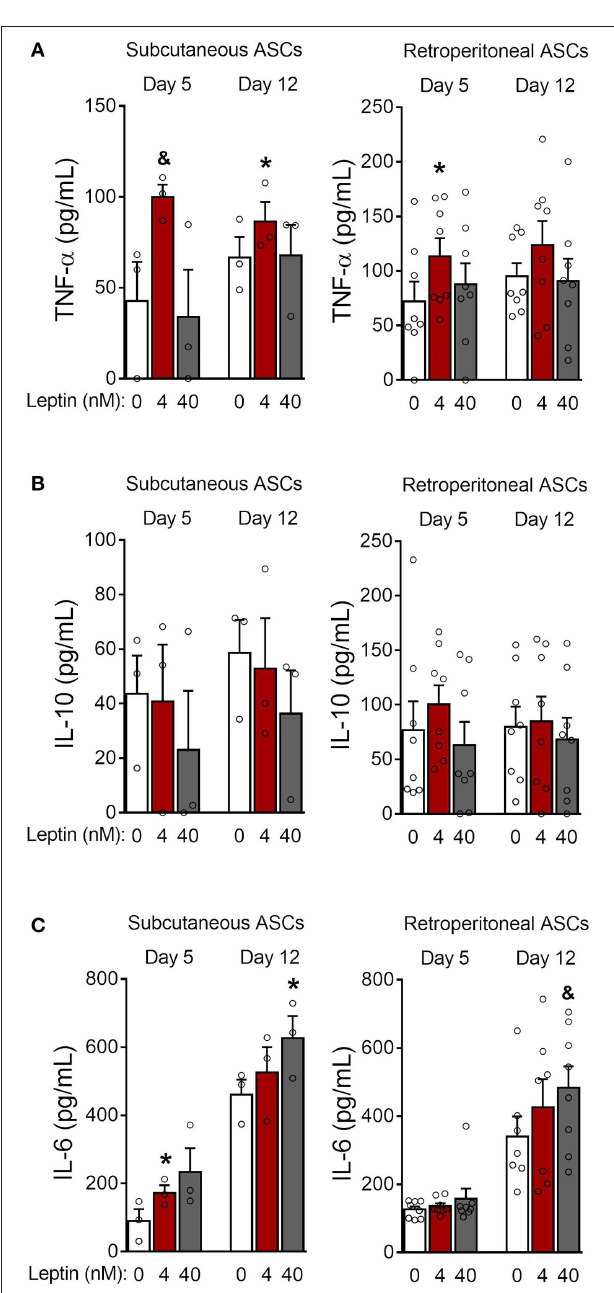
FIGURE 6 | Leptin induces a proinflammatory cytokine profile during ASCs differentiation. (A–C) ASCs from subcutaneous and retroperitoneal fat depots were differentiated for 5 and 12 days in the presence of leptin (0, 4, or 40nM) and the concentrations of (A) TNF- α , (B) IL-10, and (C) IL-6 were measured in the supernatants. Bars represent mean ± standard error of the mean of 3–8 independent experiments. * p < 0.05 and & p < 0.06 compared to ASCs differentiated in the absence of leptin at the respective timepoint. Statistical analyzes were performed using paired t